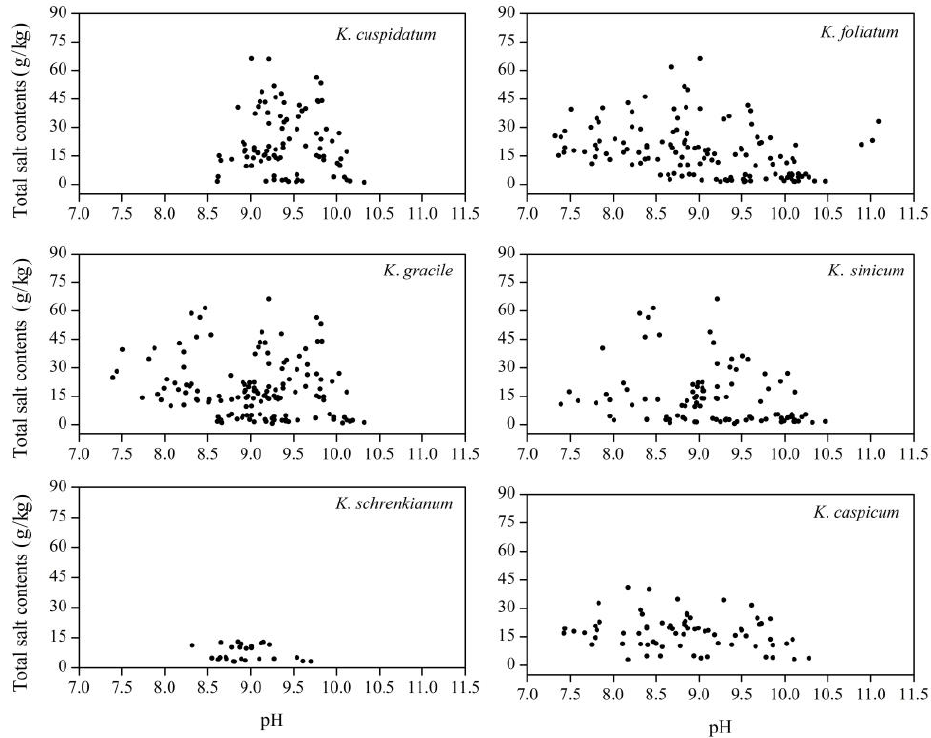
Figure 2. Scatter plots of total salt contents and pH of soil samples from areas occupied by indicated Kalidium species.